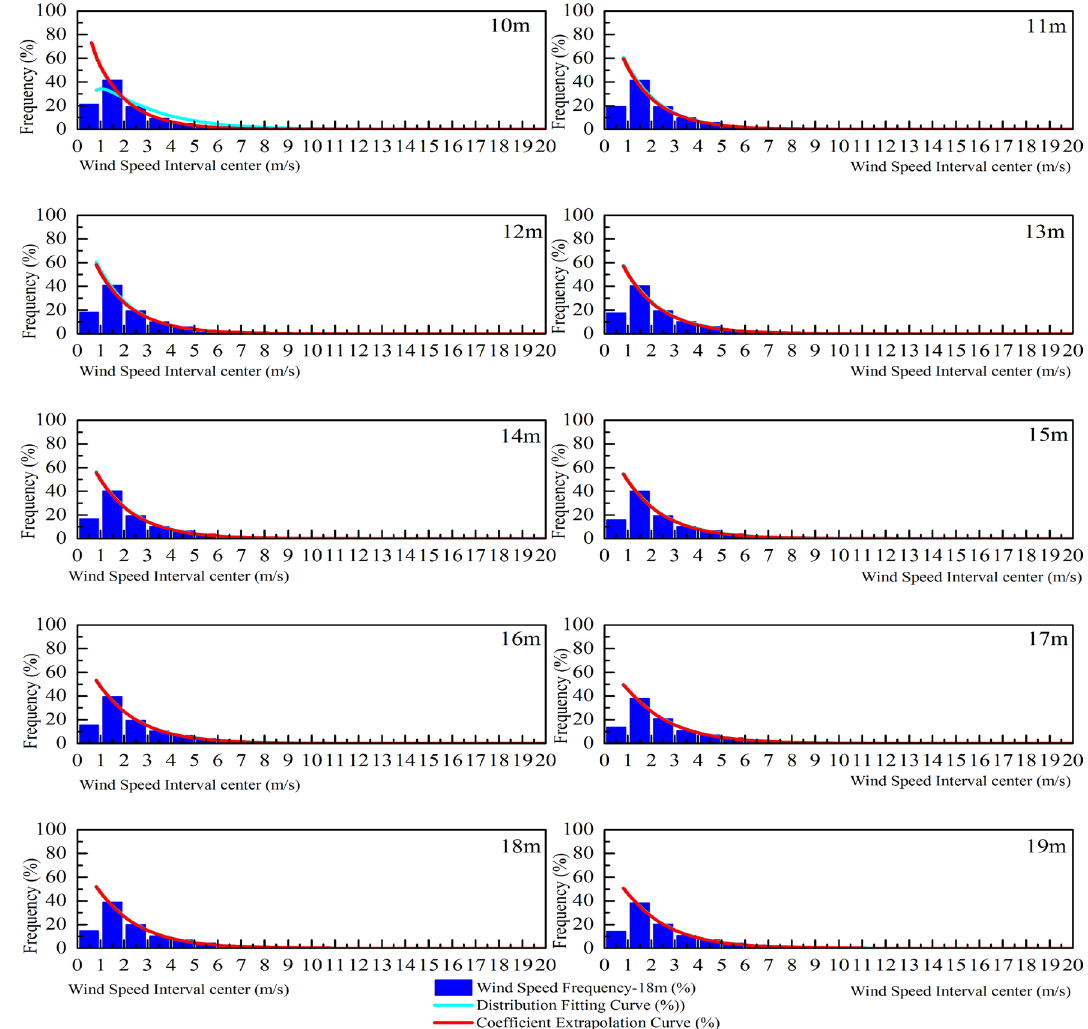
Figure 14. Probability distribution and extrapolation probability distribution curves of actual wind speed at 10–19